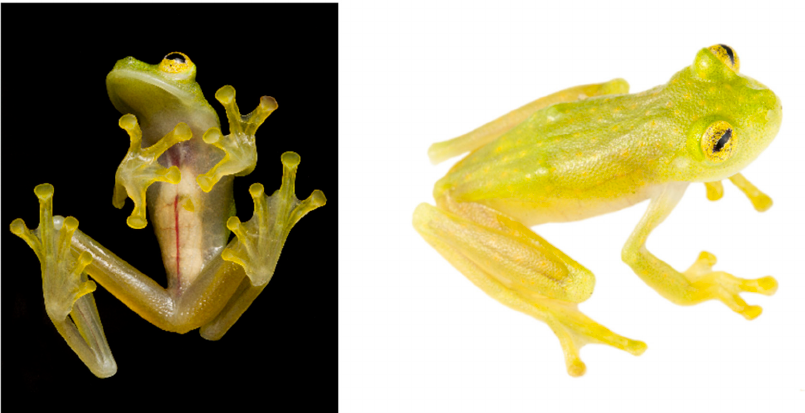
Figure 106. Hyalinobatrachium chirripoi in life. Reserva Canandé, 372 m, Esmeraldas province, Ecuador. Photos by Jaime Culebras.